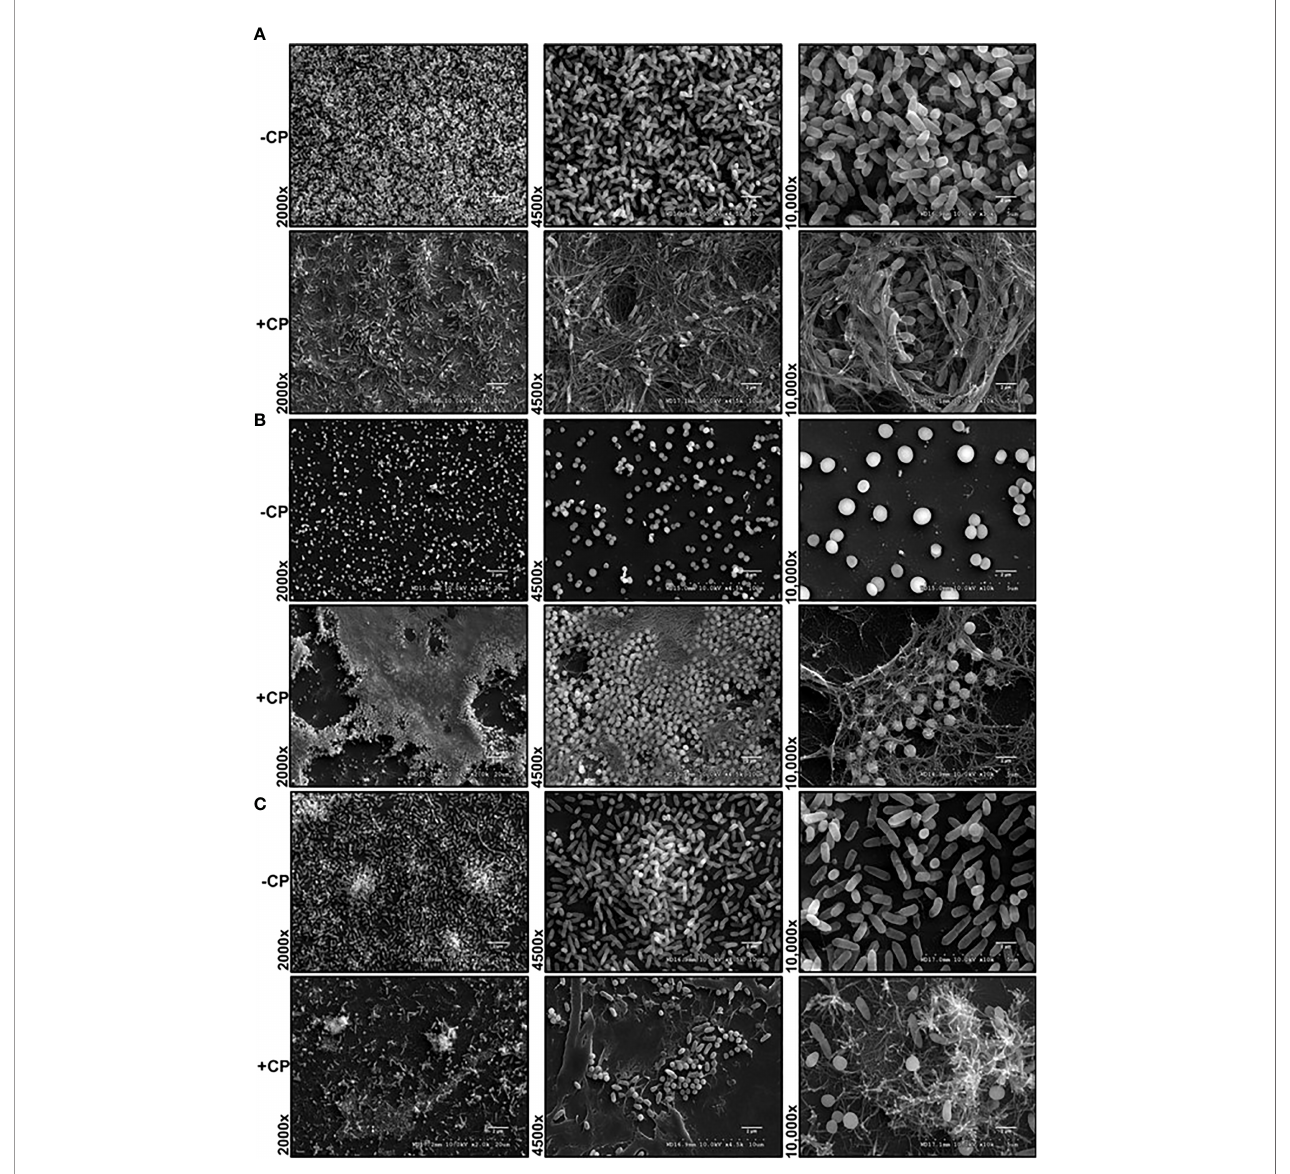
FIGURE 1 | Addition of CP to growth media leads to encapsulation of P. aeruginosa and S. aureus in a mesh-like structure. SEM images of P. aeruginosa and S. aureus bio fi lms grown as mono and co-cultures in +/- CP conditions- (A) P. aeruginosa monoculture (B) S. aureus monoculture (C) P. aeruginosa - S. aureus co- culture. Images show 2000X, 4500X, and 10,000X magni fi cation and are representative of three independent